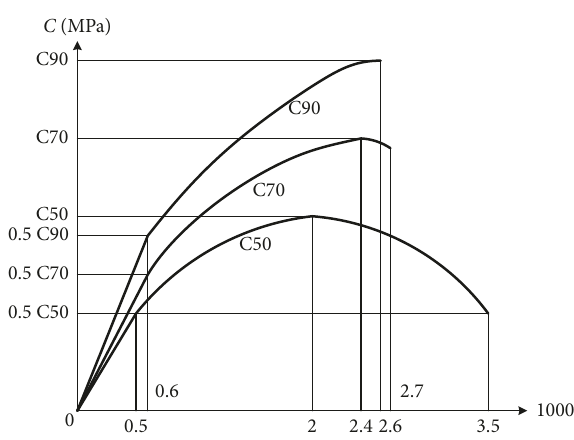
Figure 2: Stress-strain relationships for concrete classes C 50 (normal-strength concrete), C 70 (the lowest limit strength of high- strength concrete), and C 90 (high-strength concrete)